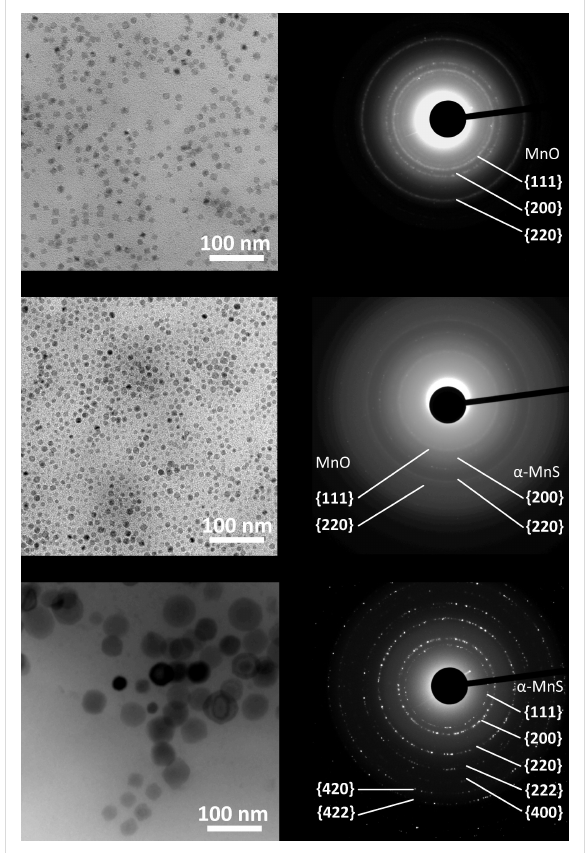
Figure 1: TEM images (left) and electron diffraction patterns (right) of NCs obtained by high temperature decomposition of Mn 2 (CO) 10 with StAc/Mn = 2 and varying amounts of sulfur. (a) S/Mn = 1, MnO NCs; (b) S/Mn = 2, mixture of MnO and α -MnS NCs; (c) S/Mn = 4, α -MnS